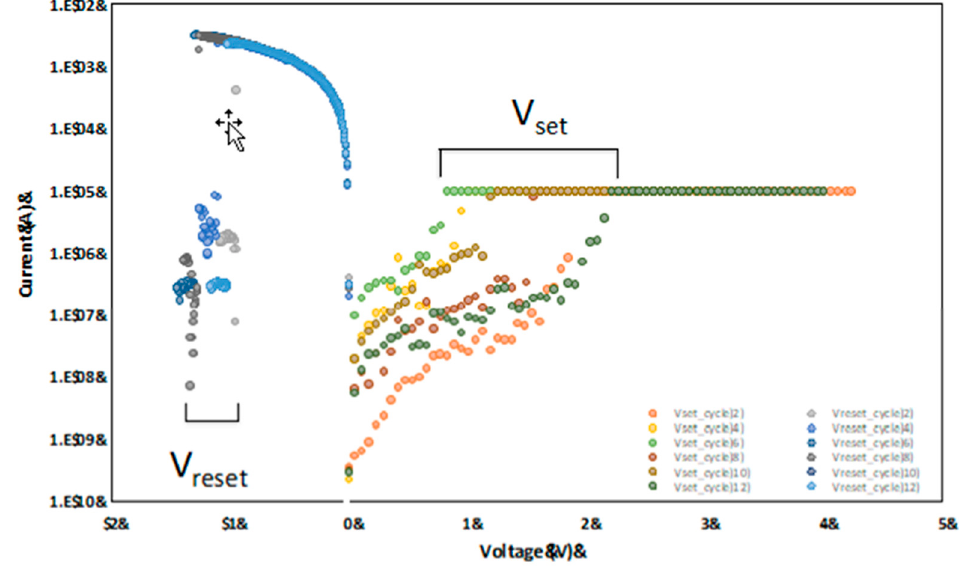
Figure 2. Even cycles of the typical first 12 switching set and reset cycles of a Cu/TaO x /Pt device.